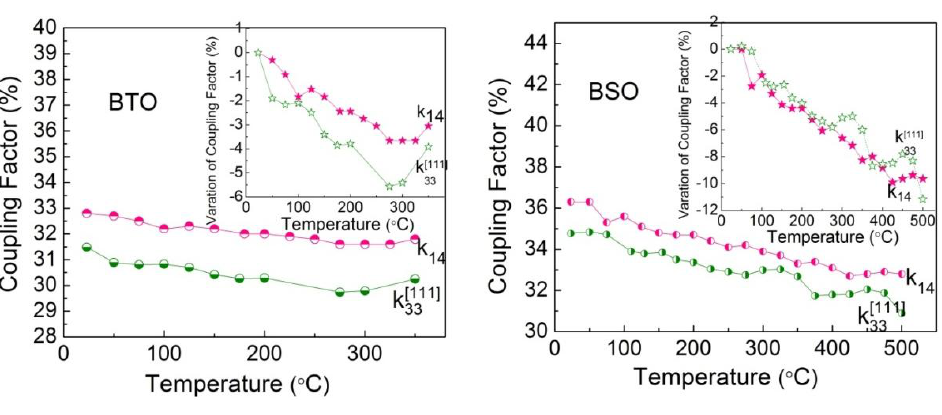
Figure 9. Coupling factor as a function of temperature for BTO and BSO